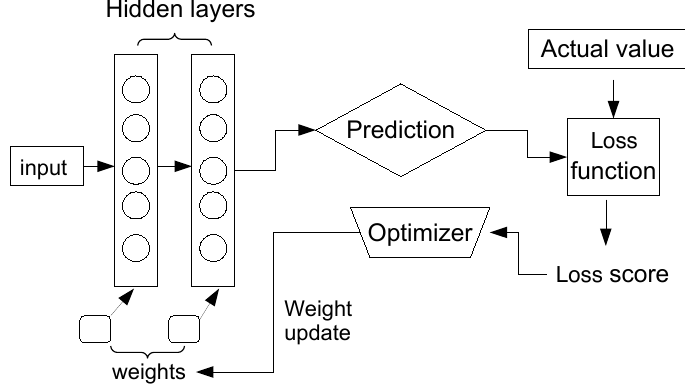
Figure 3. Interrelationship between loss function and optimiser.